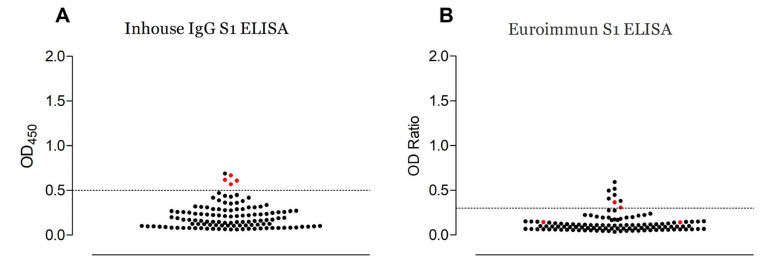
Figure 1. The testing of human serum samples for MERS-CoV antibodies, Kenya, (2016). The reactivities of individual serum samples to MERS-CoV S1—tested using in-house ( A ) and commercial ( B ) S1 ELISAs—are plotted. PRNT positive serum samples are shown in red. The dotted line indicates the cut-o ff of each assay